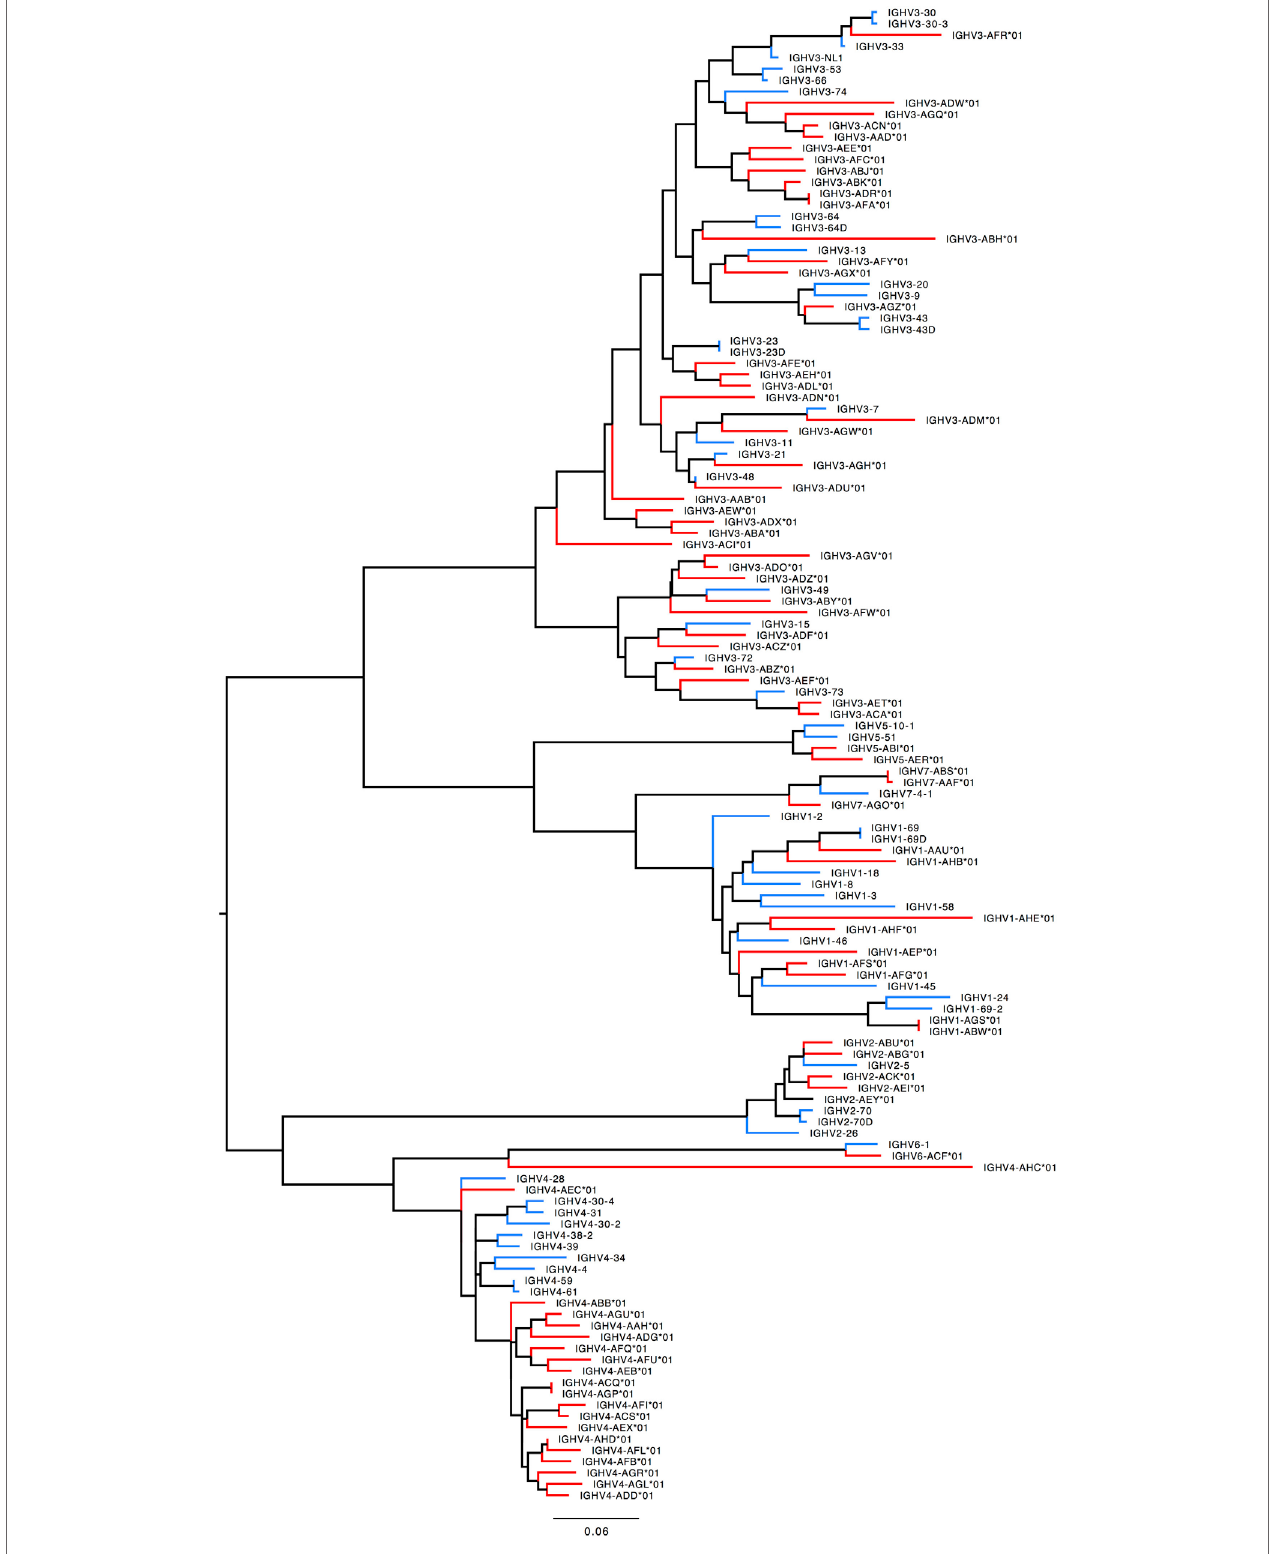
FigUre 7 | Maximum likelihood phylogenetic tree of the human and rhesus IGHV functional genes. Human immunoglobulin (Ig) V genes are represented in blue and macaque Ig V genes in